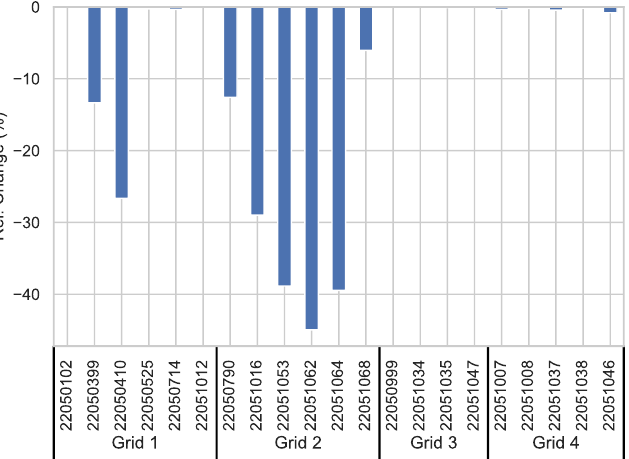
Figure 14. Comparison of activate-able flexibility between the scenario with flexibilities with a reduced and with a large volume